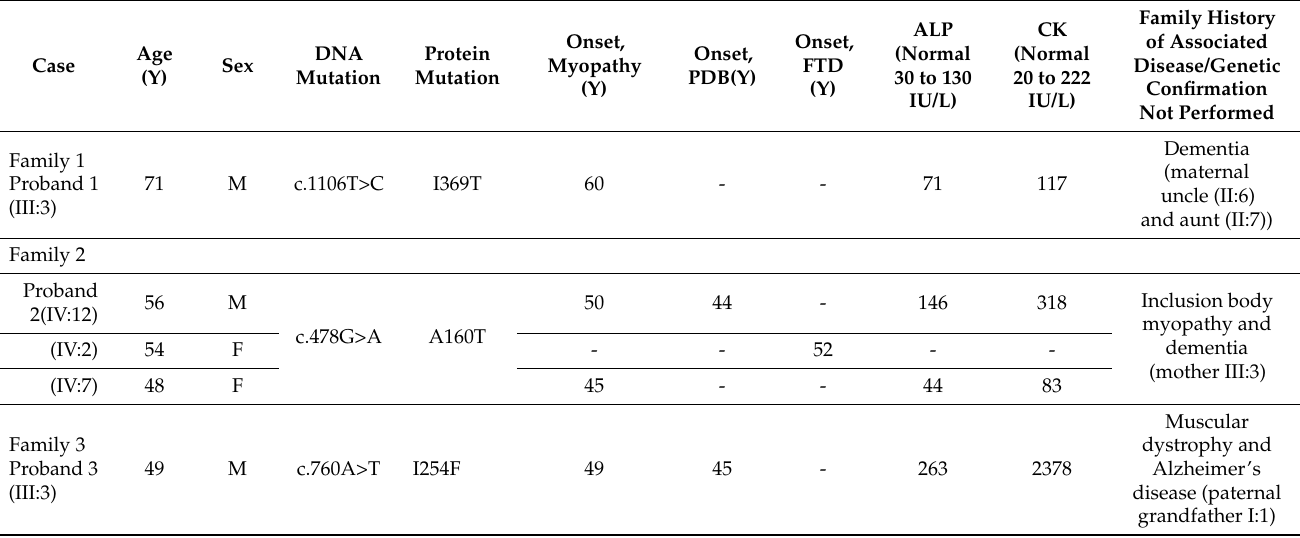
Table 1. Clinical features of the MSP1 patients with novel VCP gene